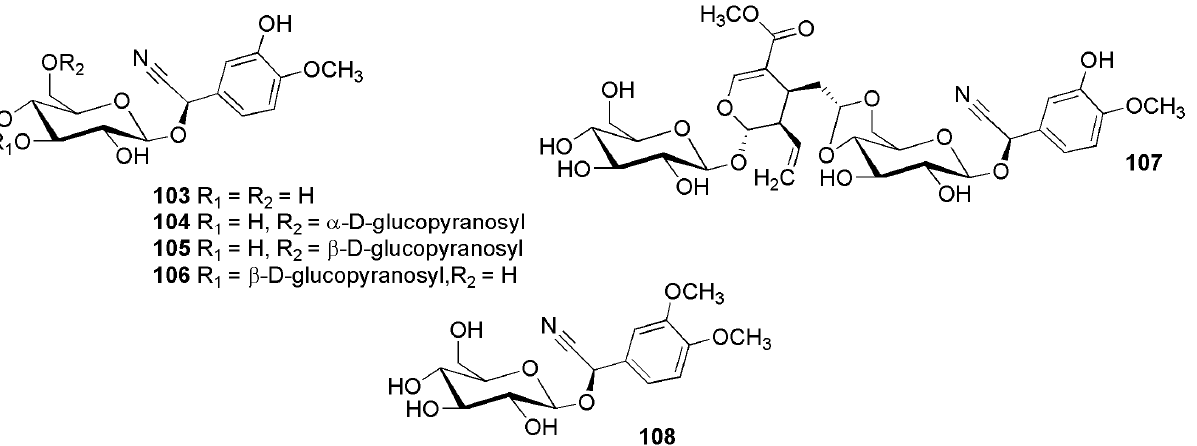
Figure 17. Cyanogenic glycosides group C-7, 3-hydroxy-4-methoxyphenyl and 3,4-dimethoxyphenyl derivatives: hydra- cyanoside A ( 103 ) (2 R )-2-[ α - D -glucopyranosyl-(1 → 6)- β - D -glucopyranosyloxy]-2-(3-hydroxy-4-methoxyphenyl) acetonitrile ( 104 ), hydracyanoside B ( 105 ), hydracyanoside C ( 106 ), hydracyanoside D ( 107 ) and (2 R )-2-( β - D -gluco-pyranosyloxy)-2-(3,4- dimethoxyphenyl) acetonitrile ( 108